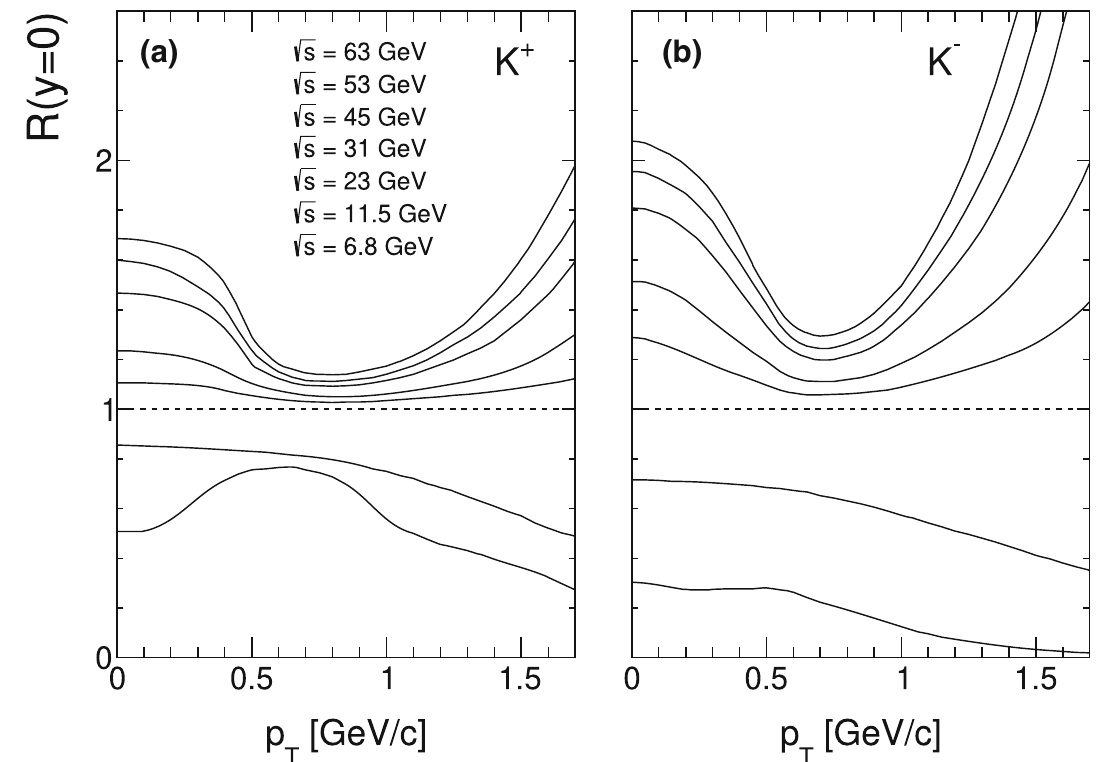
√ s values between 6.8 and 63 GeV